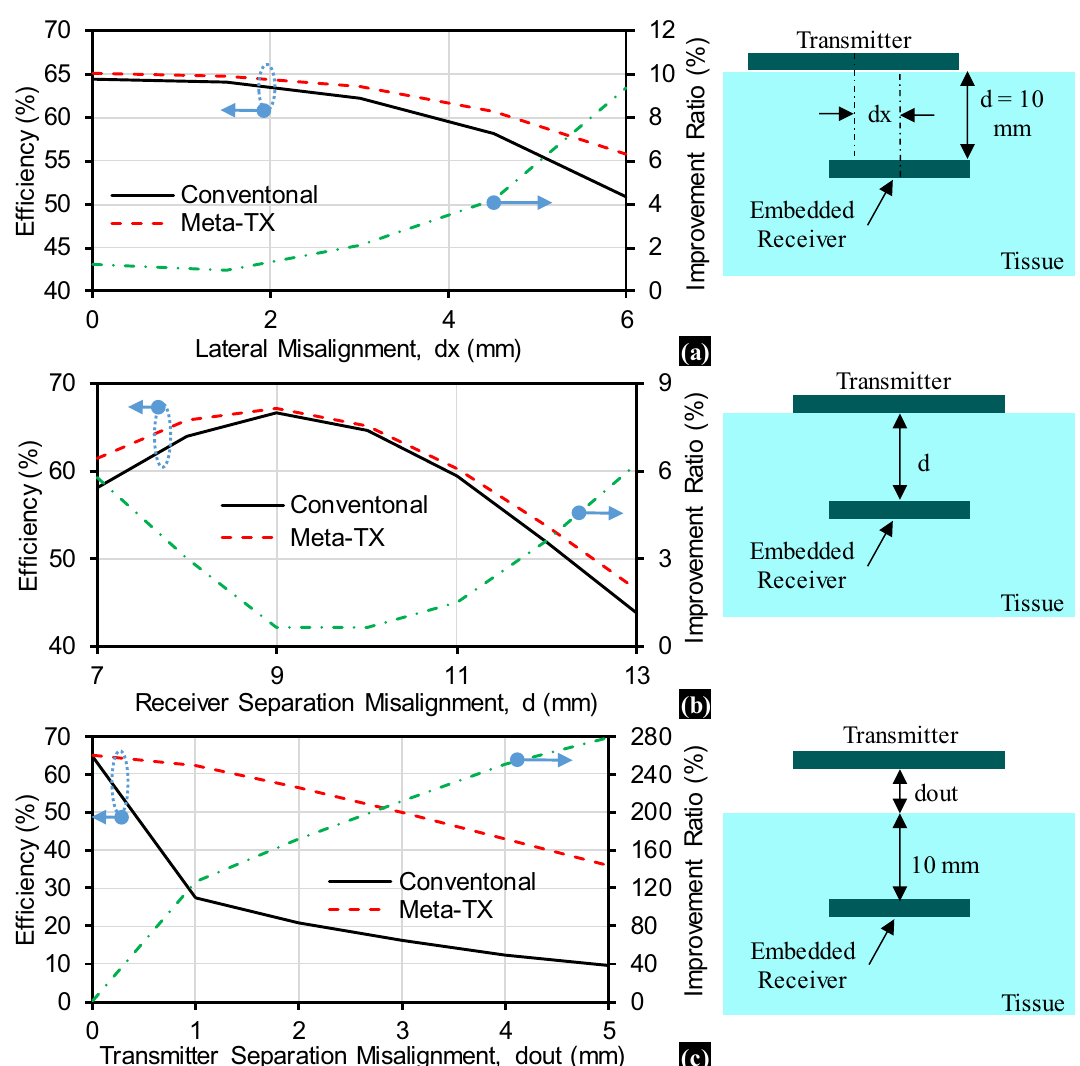
Figure 4. Simulated efficiency comparison between conventional and proposed metamaterial inspired WPT systems during misalignment (a) Lateral Misalignment. (b) Receiver Separation misalignment inside the tissue. (c) Transmitter separation misalignment from the